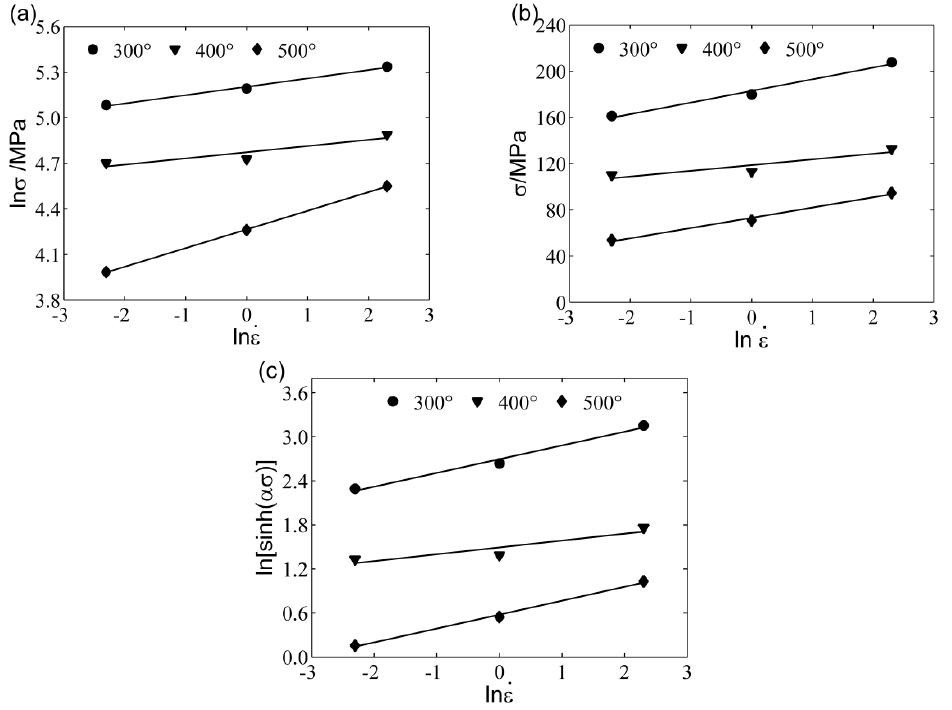
. . ε ; ( b ) σ vs. ln ε ; and ( c ) ln [ sinh ( ασ )] vs. ln